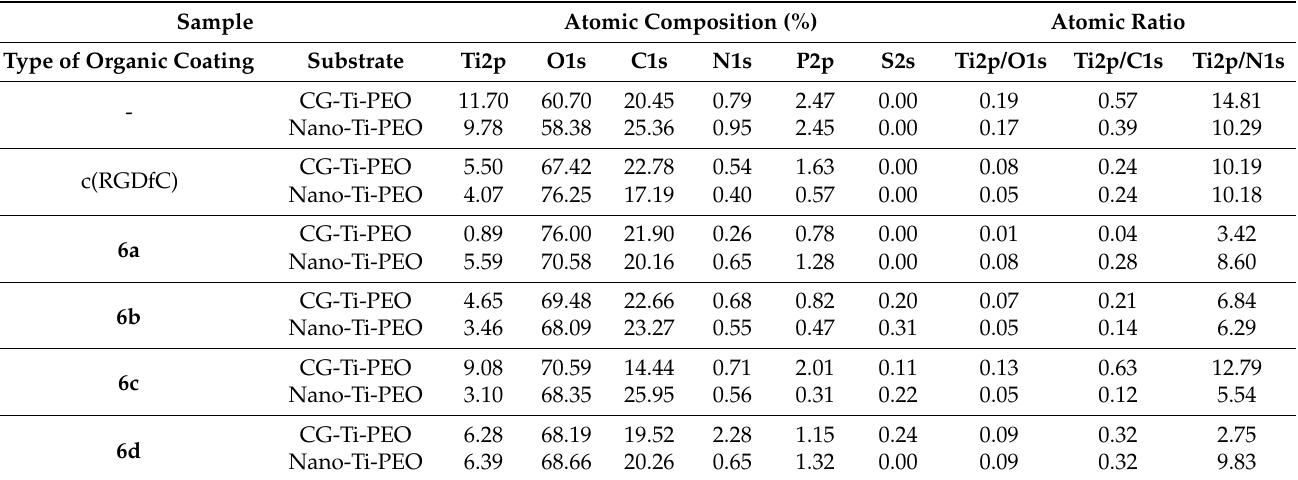
Table 3. Atomic composition and ratio for the Ti-PEO samples obtained from XPS high-resolution spectra.